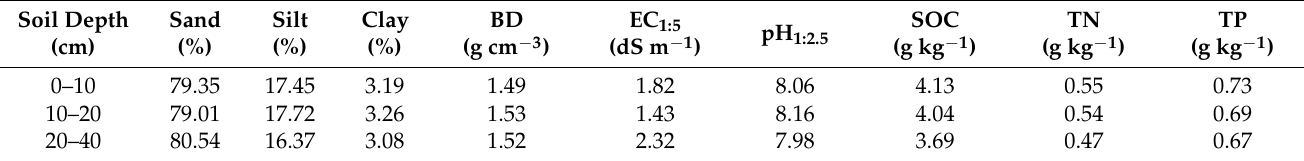
Figure 1. Location of the study area. Table 1. Soil properties before field experiment.